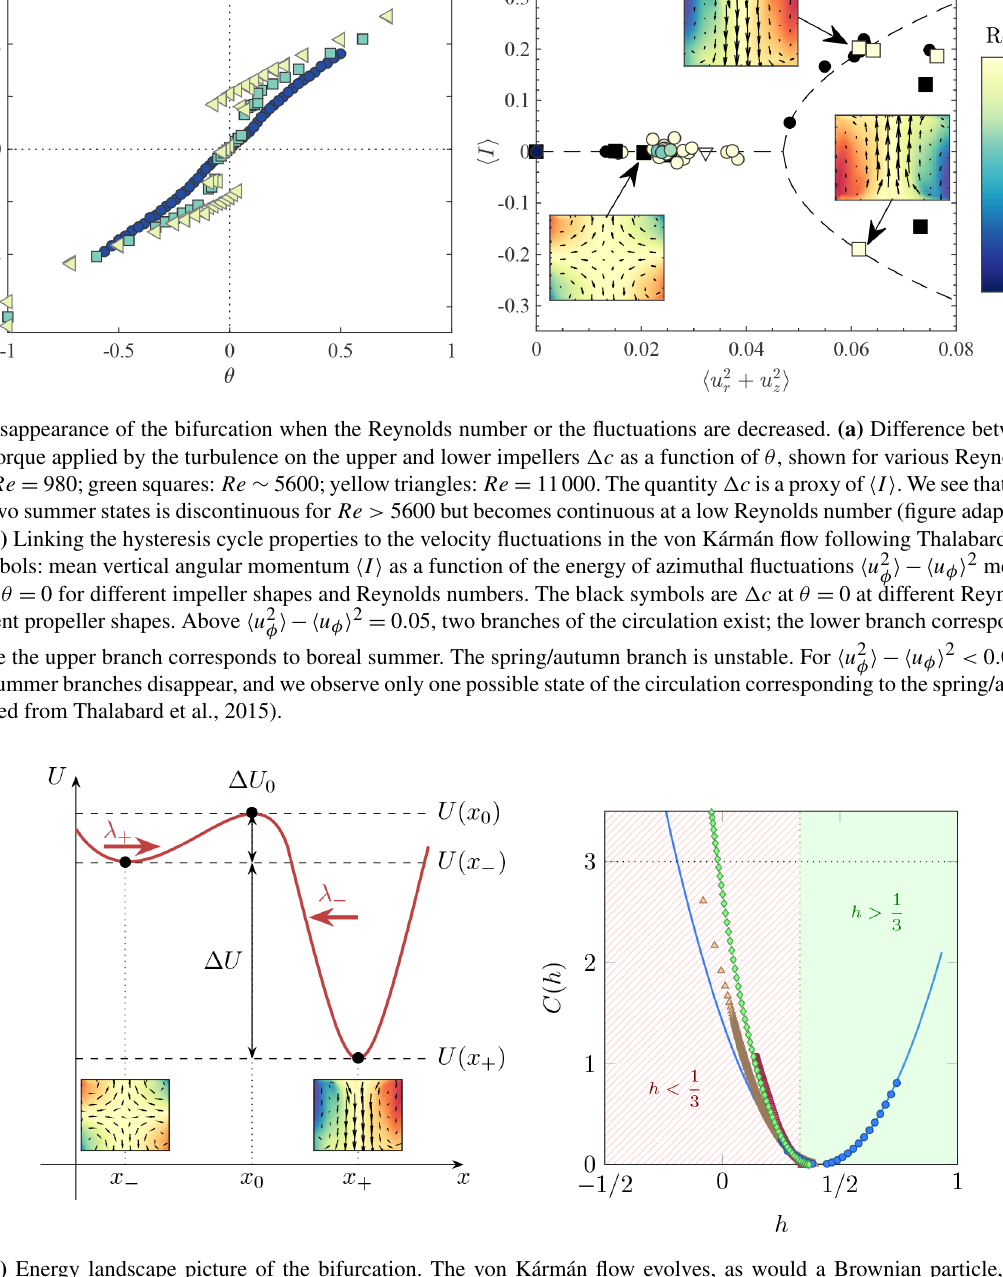
Figure 11. (a) Energy landscape picture of the bifurcation. The von Kármán flow evolves, as would a Brownian particle, between two potential wells of different depths U(x − ) and U(x + ) separated by energy barriers (cid:49)U 0 or (cid:49)U + (cid:49)U 0 depending on the nature of the transition. (b) Multifractal spectrum exponent C(h) of the wavelet velocity increments (equivalent to | δ (cid:96) u | ) computed using Eq. (3) on numerical simulation data of the von Kármán flow obtained by Hugues Faller. The data points are given by blue circles, and the blue line is a parabolic fit extrapolating towards C(h) = 3 which cannot be accessed with our limited data set. For comparison, we have also put the multifractal spectrum exponent computed from the scaling properties of the local energy transfer (green diamonds) in the same numerical simulation. Finally, we have added to the graph multifractal exponents derived from scaling exponents measured by Iyer et al. (2020) through the moments of the signed longitudinal (red squares) and transverse (yellow triangle) velocity increments (figure adapted from Faller et al.,